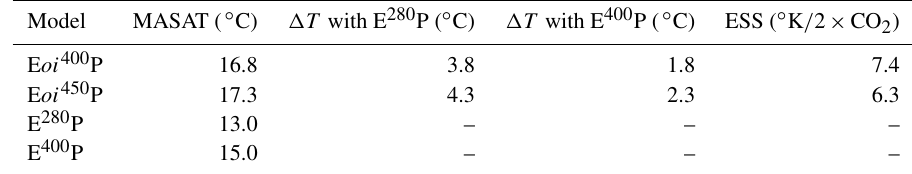
Table 5. Mean annual surface air temperatures (MASATs) and Earth system sensitivity (ESS).